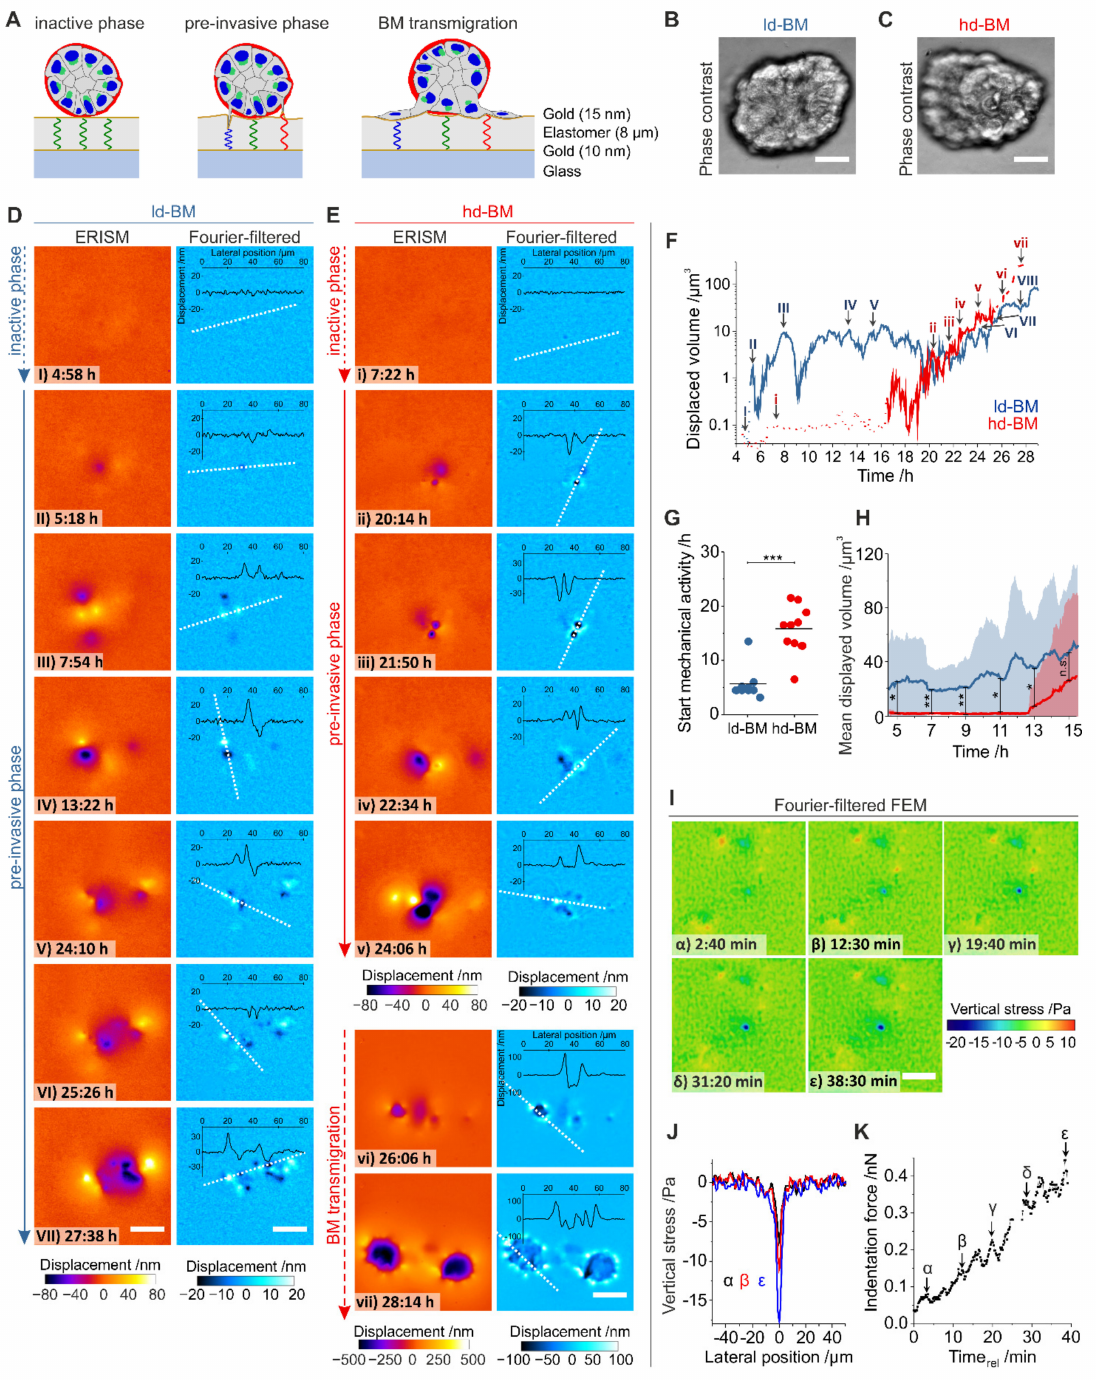
Figure 4. Measurement of mechanically active protrusions of pre- and post-invasive breast acini. ( A ) Schematic illustration of the elastomer resonance interference spectroscopy microscopy (ERISM) measurement. An acinus is seeded on an elastic and soft ERISM chip (apparent stiffness: 3 kPa, functionalized with type IV collagen). During the pre-invasive phase, cell protrusion forces deform the ERISM chip locally, leading to local changes to the resonance wavelengths of the ERISM chip, which are detected optically. After BM transmigration, cells adhere to the chip surface exerting contractile force. ( B ) Phase-contrast image of a representative ld-BM acinus and ( C ) of a hd-BM acinus. ( D ) ERISM displacement maps (left column) and Fourier-filtered ERISM displacement maps (right column) for the ld-BM acinus shown in ( B ) at different timepoints. Insets show lateral profiles along the white dotted lines. ( E ) ERISM displacement maps (left column) and Fourier-filtered ERISM displacement maps (right column) for the hd-BM acinus shown in ( C ) at different timepoints.